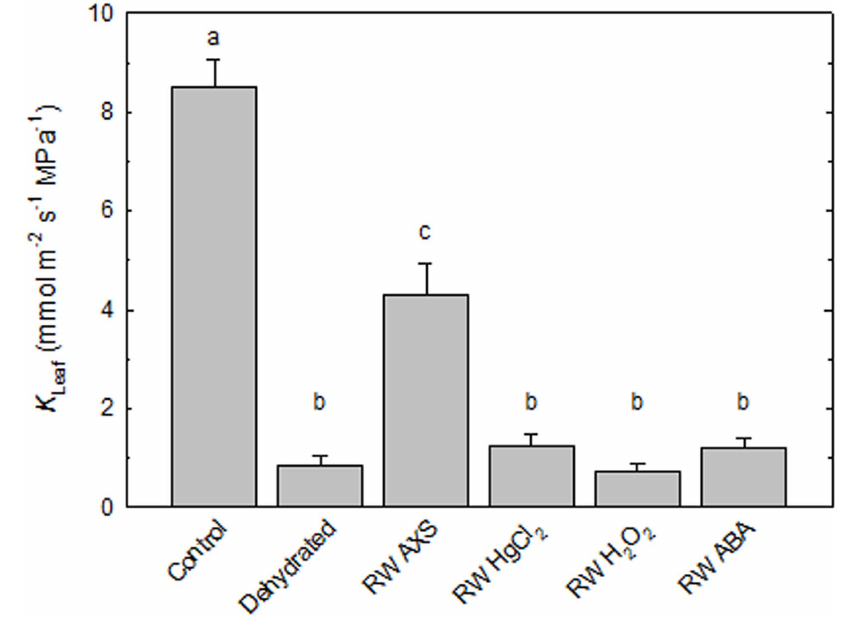
Figure 3. Response of leaf hydraulic conductance (A) and stomatal aperture (B) to different perfusion solutions. Control conditions refer to the K leaf that was measured after leaves were xylem perfused with filtered (0.2 m m) 20 mM KCl + 1 mM CaCl 2 solution (subsequently referred to as ‘artificial xylem sap’, AXS) for 2 h. K leaf was also measured on leaves that were bench-dried for 1 h (Dehydrated) and on leaves that were bench- dried for 1 h and subsequently perfused for 2 h with AXS (RW AXS), AXS + 0.2 mM HgCl 2 (RW HgCl 2 ), AXS + 50 mM H 2 O 2 (RW H 2 O 2 ) or AXS + 50 m M ABA (RW ABA). Values are means 6 SE (n=6). Different letters denote statistically significant differences by one-way ANOVA with Tukey’s test.